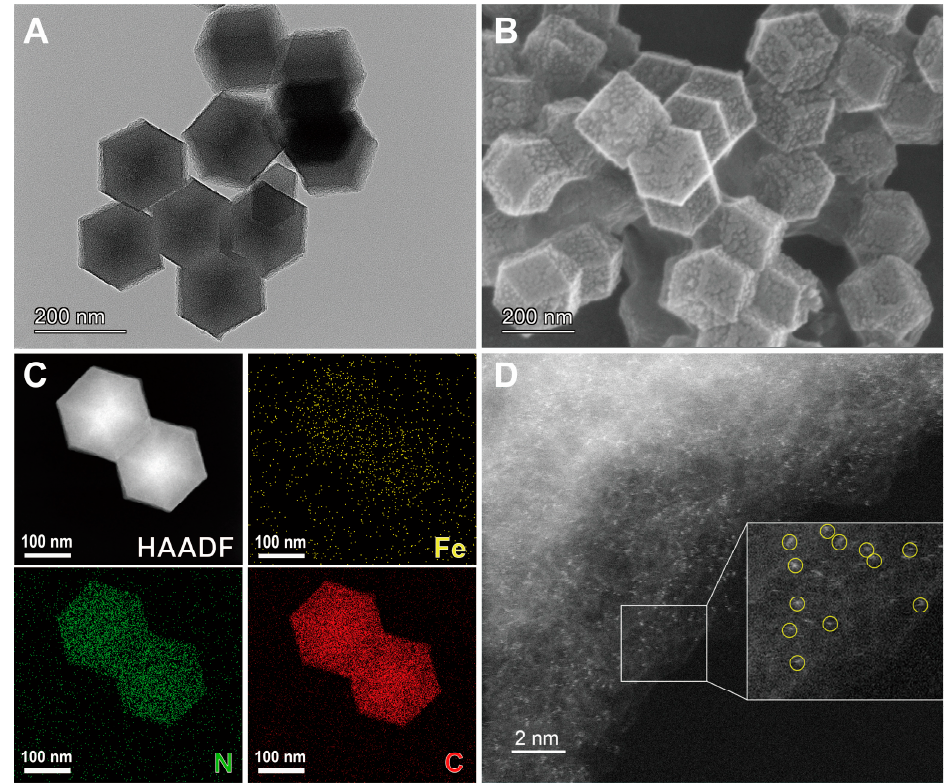
Figure 1. TEM ( A ) and SEM ( B ) images of Fe-N-C. ( C ) HAADF-STEM image and corresponding EDS elemental mapping of Fe, N, and C for the Fe-N-C catalyst. ( D ) AC-HAADF-STEM image of Fe-N-C.